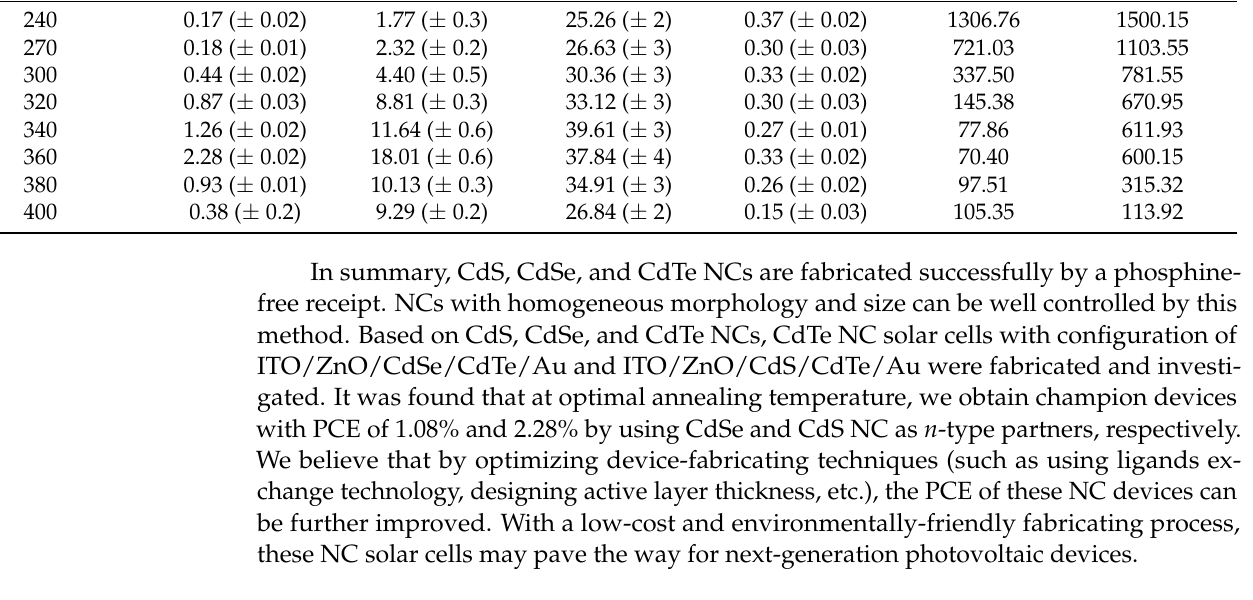
Table 2. Summarized performance of CdTe/CdS NC solar cells with different annealing temperatures (Figure 5b).